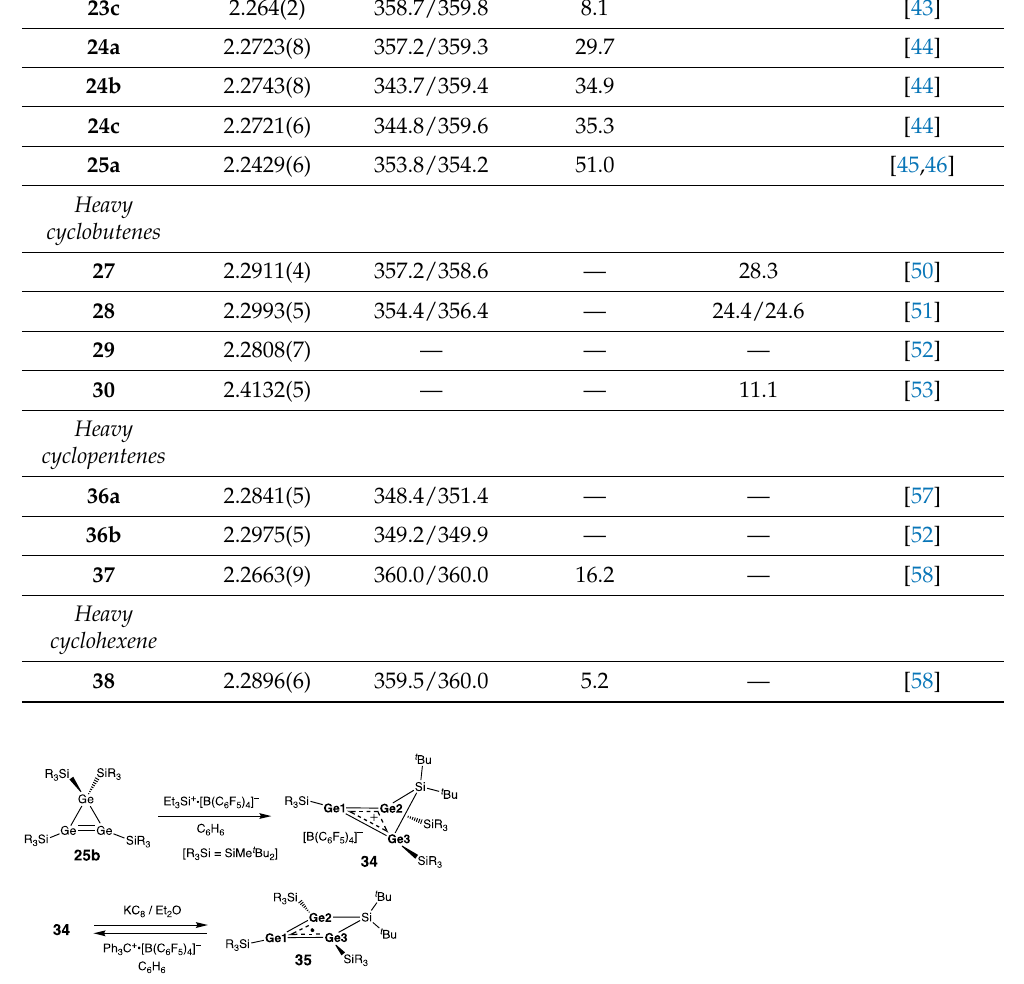
Molecules 2023 , 28 , x FOR PEER REVIEW 12 of 36